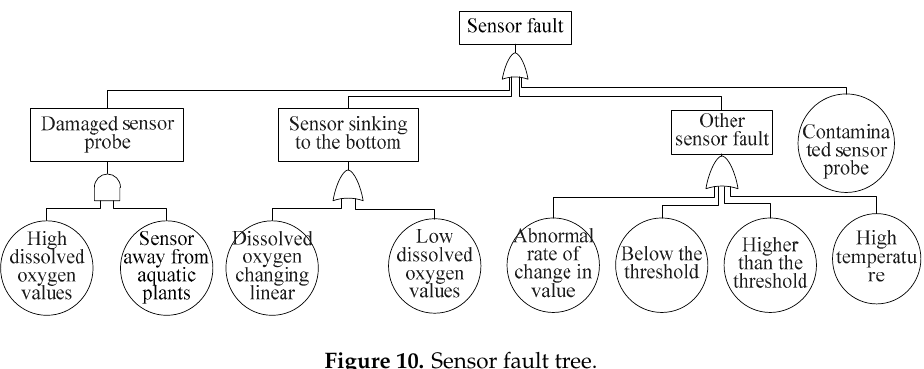
Figure 10. Sensor fault tree.